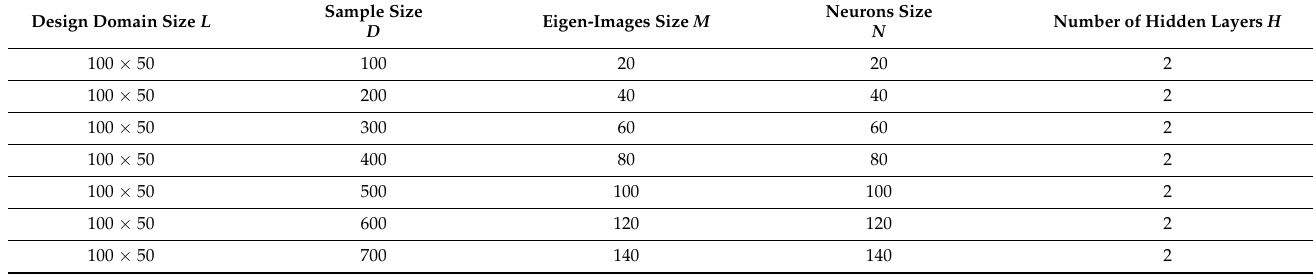
Table 1. Network parameter setting.